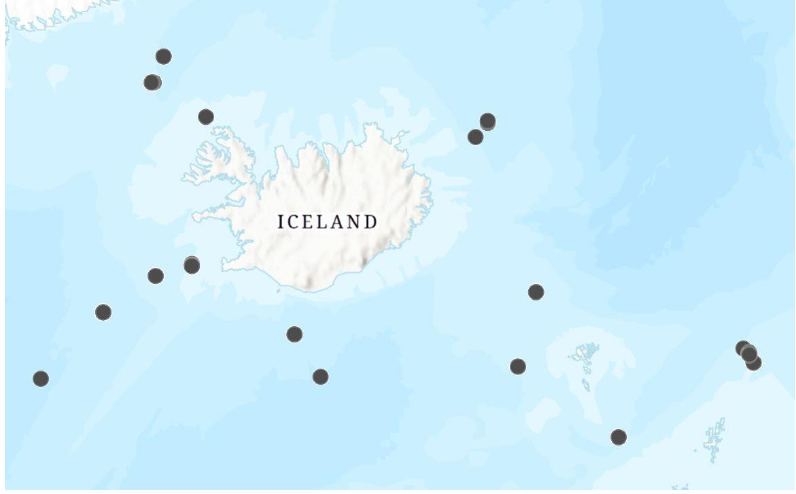
Figure 2. Sampling locations for euphrosinids collected during the IceAGE I cruise.